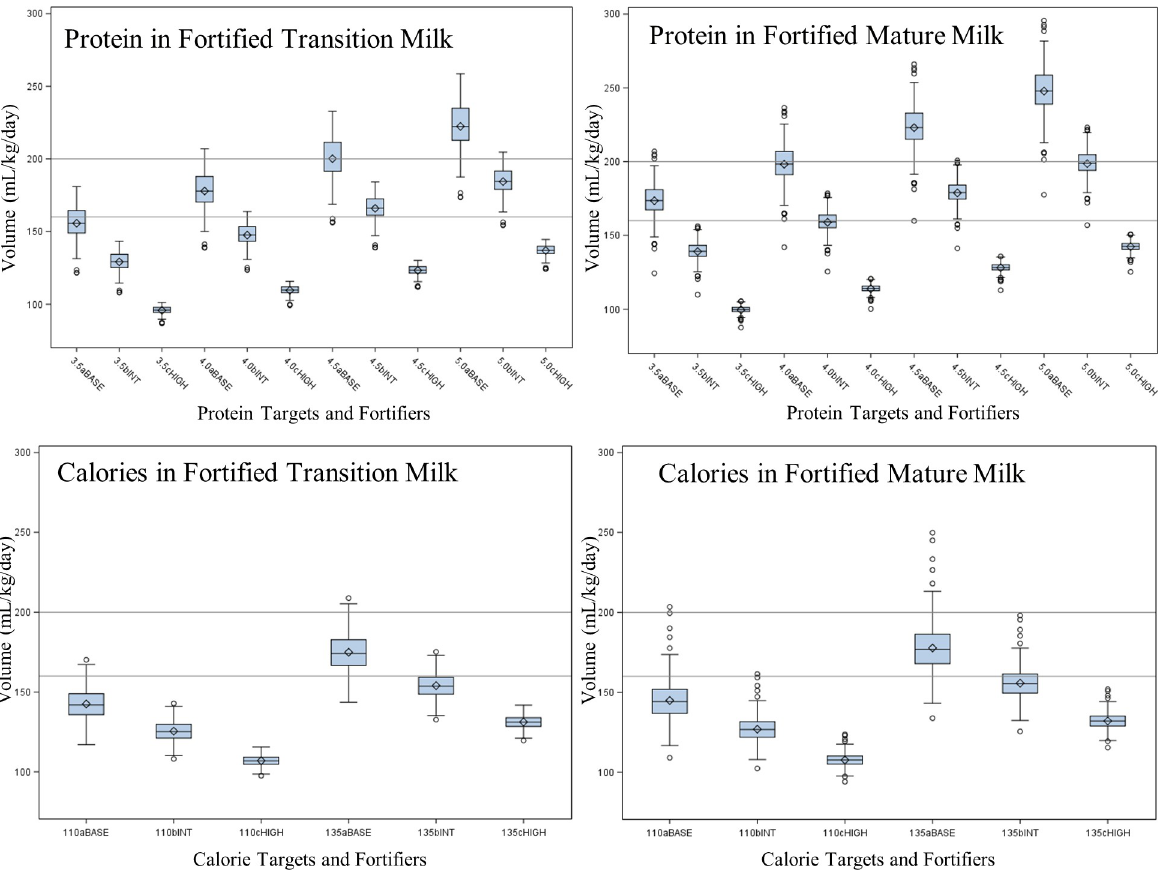
Fig 2. Box and whisker plots of feeding volumes to achieve various protein and calorie targets using commercial fortifiers. Base (BASE), intermediate (INT), and high (HIGH) protein and calorie fortifiers in 443 Donor Pools from 443 unique donors providing either milk < = 4 weeks postpartum (N = 148) or > 4 weeks postpartum (N = 295). Grey rectangles represent quartile 1 to quartile 3 values. Within rectangles, the median is represented by–and the mean is represented by ^ . Reference lines: 200 ml/kg/day represents ESPGHAN maximum feeding volume; 160 ml/kg/ day represents common NICU target volume.